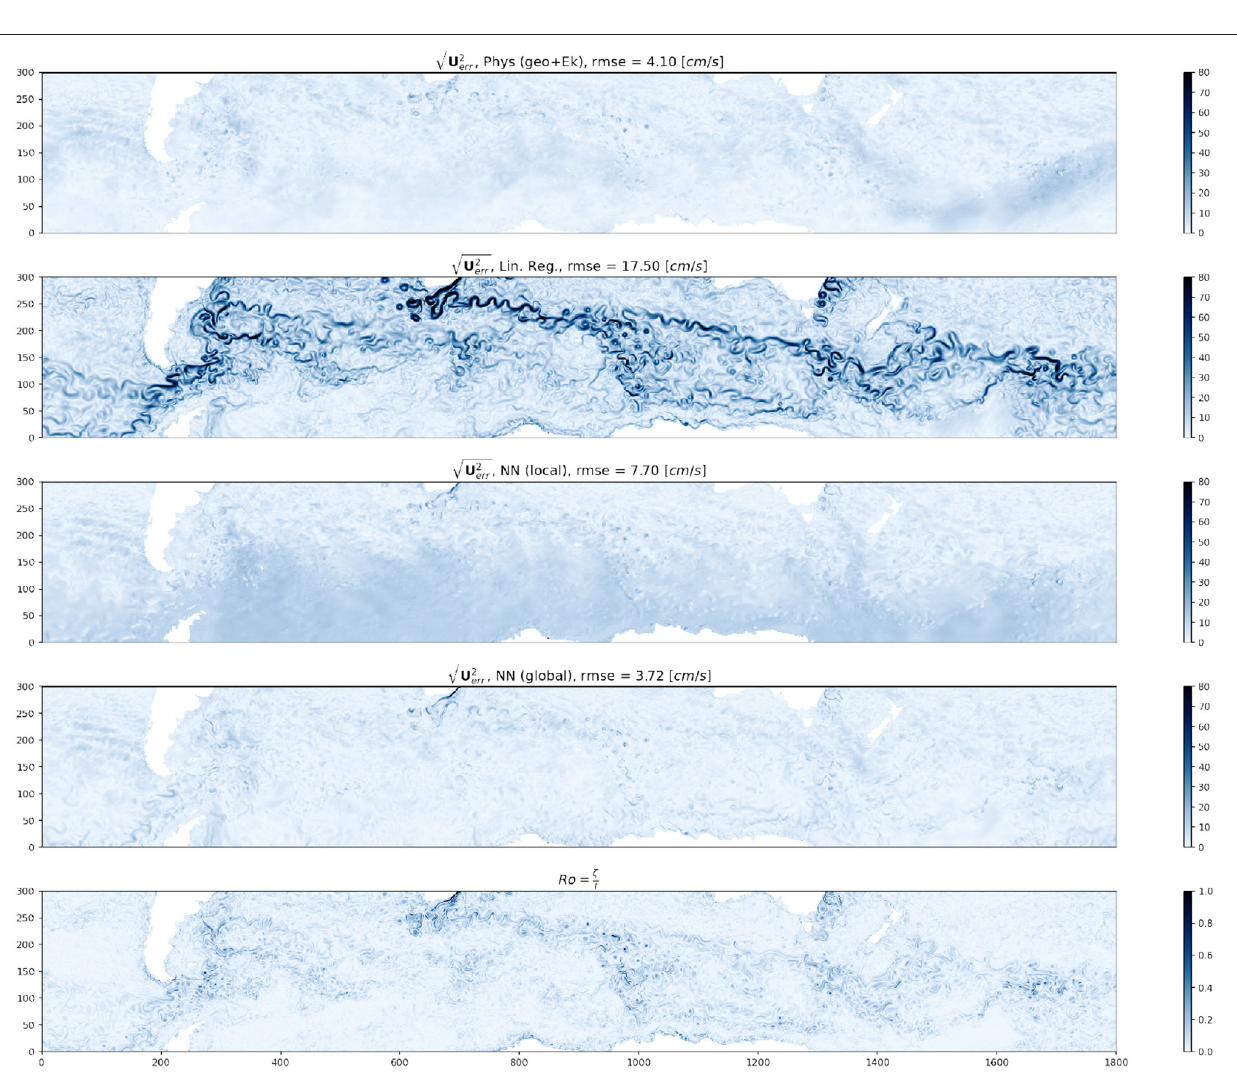
Frontiers in Marine Science |